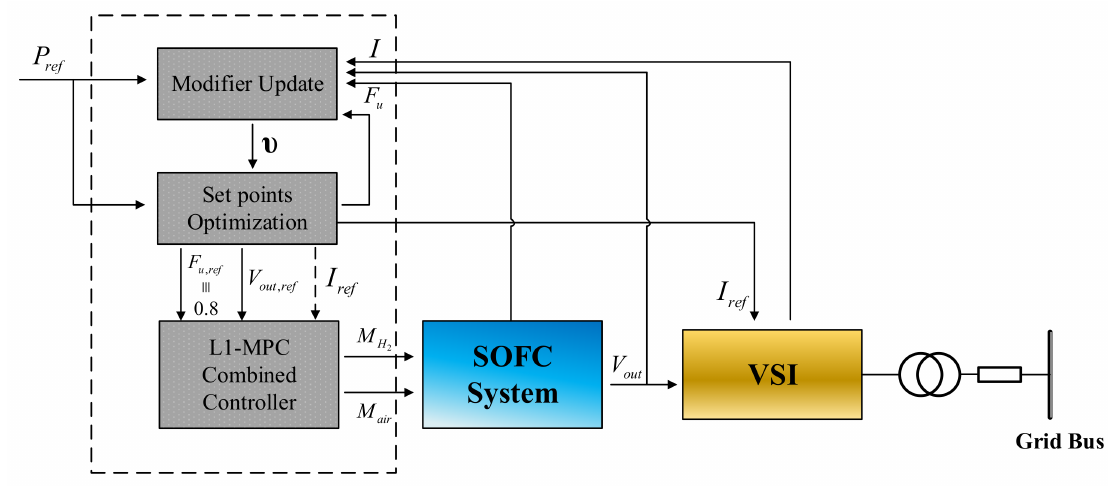
Figure 4. The hierarchical control structure for optimal SOFC